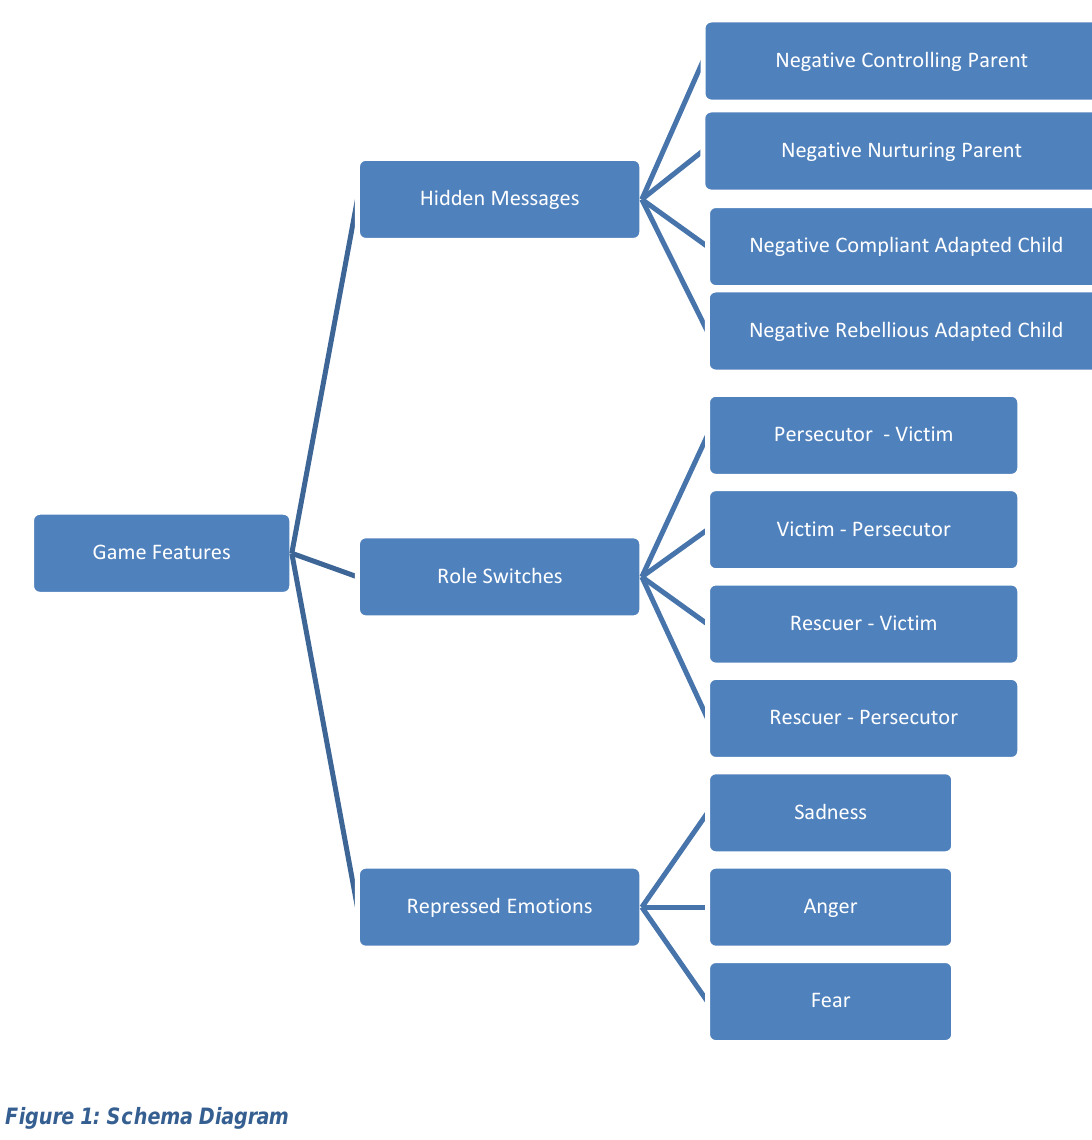
Data was collected for the pre-test and the final questionnaire about gender, age, education and occupation variations. Statistical analyses were done using SPSS 25.0 and AMOS